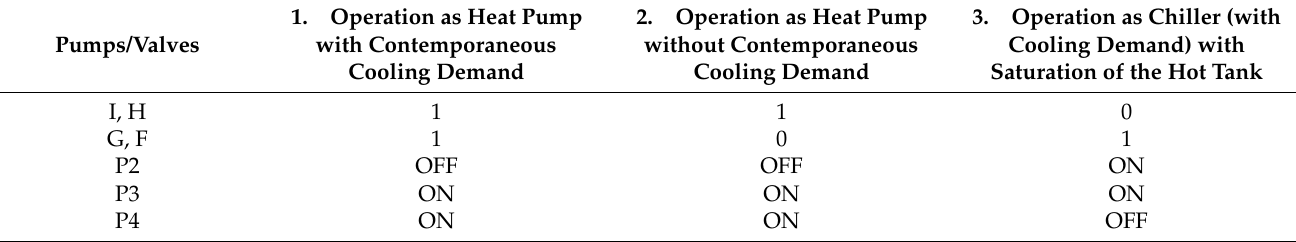
Table 3. Status of pumps and valves control variables for the HP–chiller loop (refer to Figure 7).